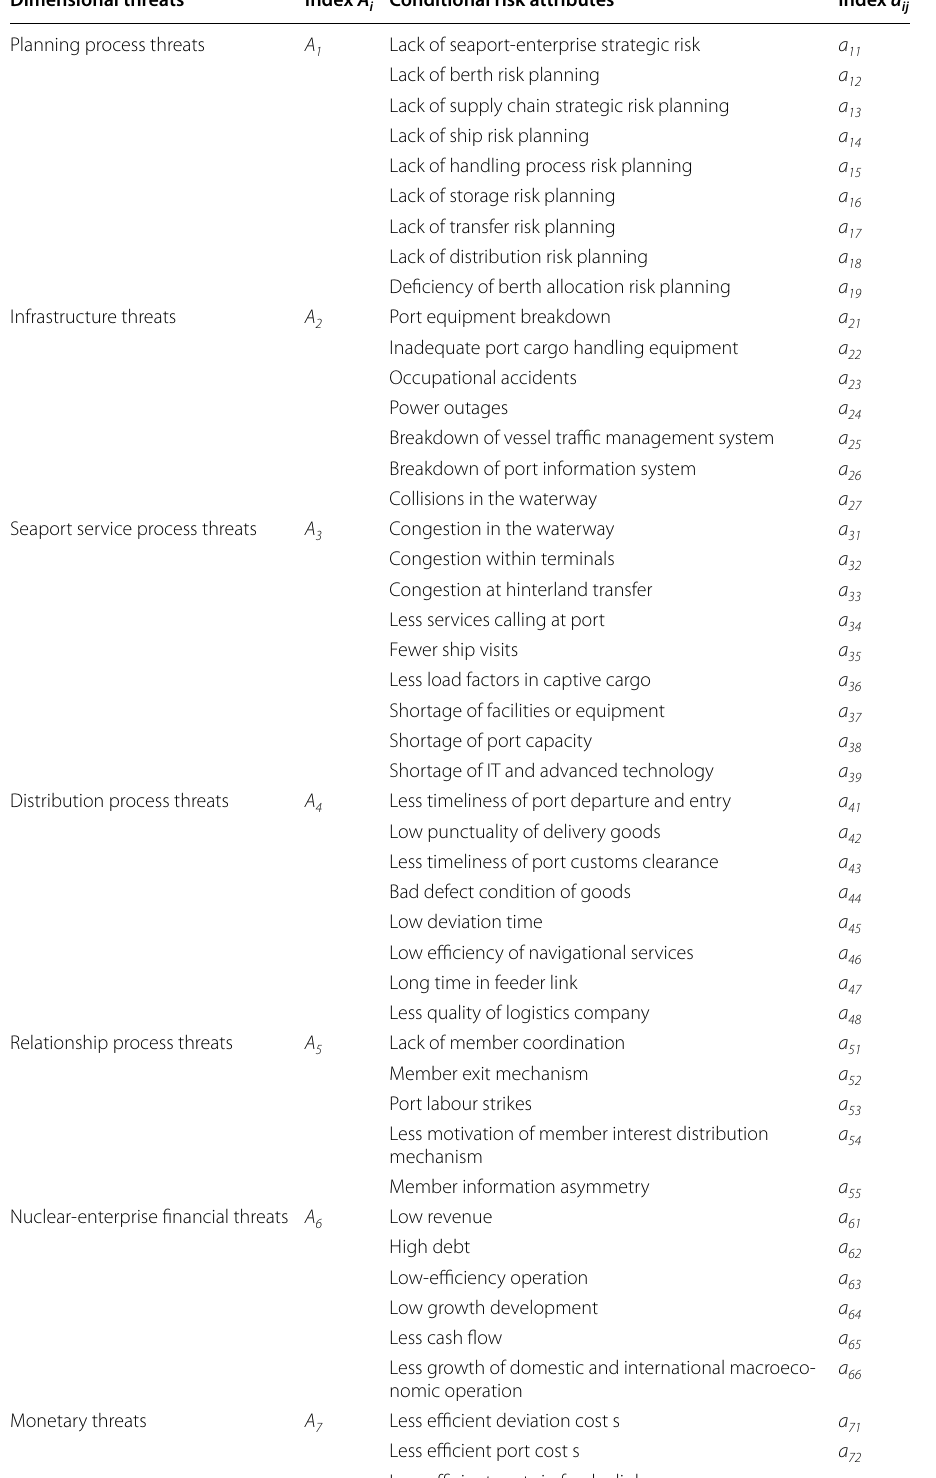
Table 1 Seaport-fulcrum supply chain risk factors Dimensional